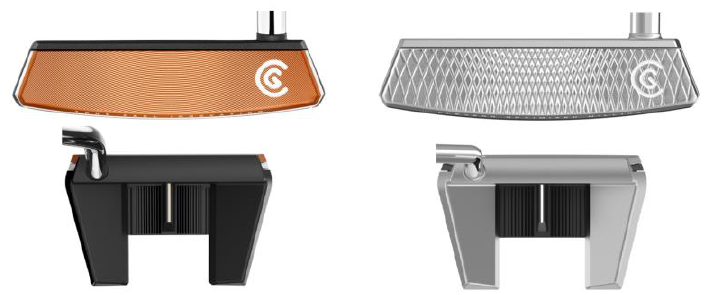
Figure 6. Putter with light uniform milling ( left ) and variable milling ( right ).